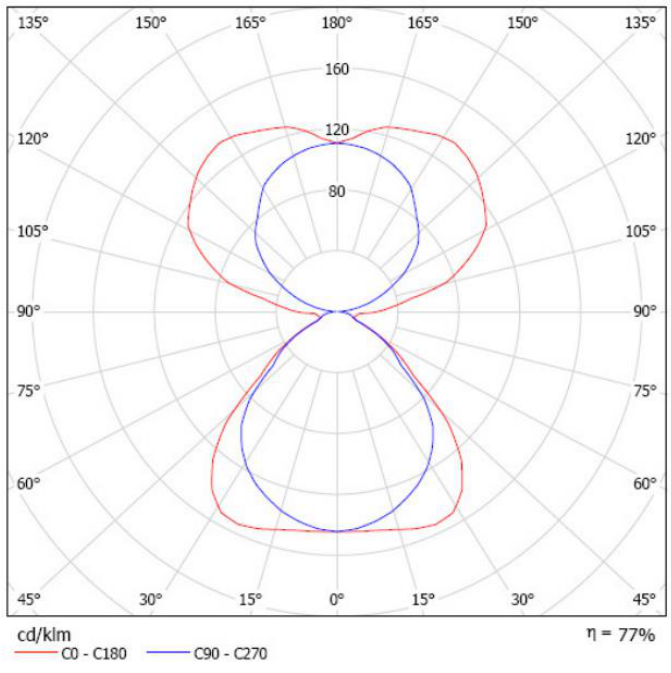
Figure 7. Light emission (simulated environment).